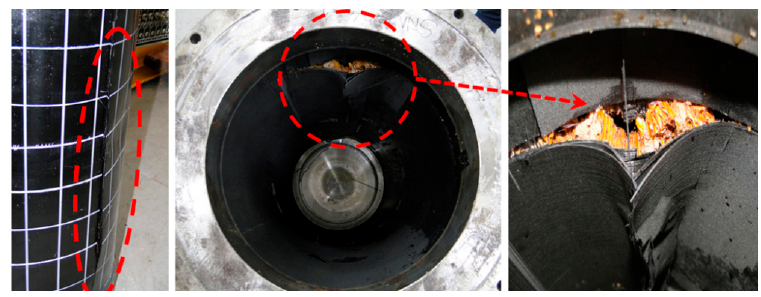
Figure 10. Failure mode of composite sandwich cylindrical shell